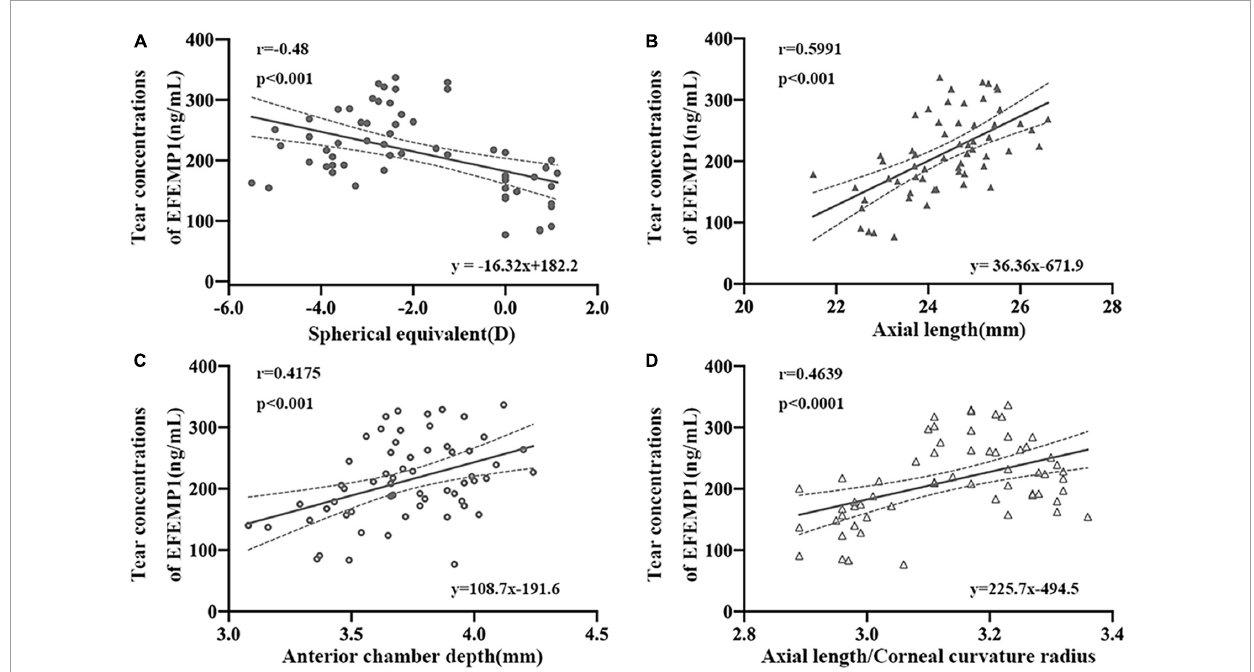
FIGURE6 Correlation between tear concentrations of EFEMP1 and ocular biometric parameters in two groups. (A) Spherical equivalence. (B) Axial length. (C) Anterior chamber depth. (D) Axial length/Corneal curvature radius. • , ◦ , (cid:52) , (cid:78) : scatter